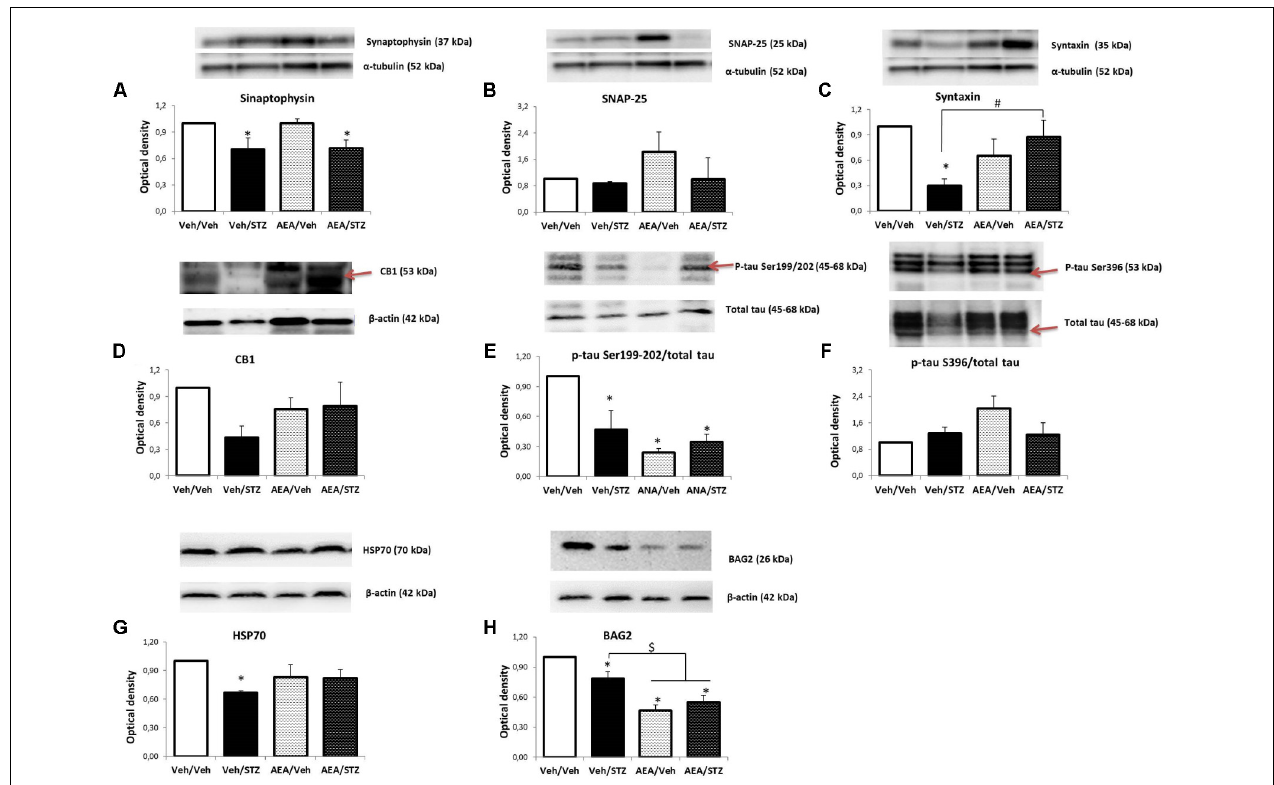
FIGURE 5 | Levels of synaptophysin (A) , SNAP-25 (B) , syntaxin (C) , CB1 receptor (D) , p-tau Ser199/202/total tau (E) , p-tau Ser396/total tau (F) , HSP70 (G) , and BAG2 (H) in the hippocampus of Wistar rats icv-treated with AEA and/or STZ (Veh/Veh, Veh/STZ, AEA/Veh, and AEA/STZ), quantified by Western blotting. Synaptophysin, SNAP-25 and syntaxin levels were normalized by α -tubulin levels. CB1 receptor, HSP70 and BAG2 levels were normalized by β -actin levels. P-tau Ser199/202 and Ser396 levels were normalized by total tau levels. Data are represented as means ± S.E.M of the percentage of groups treated with AEA and/or STZ compared to Veh/Veh, which was considered 1.0 ( n = 3-5 animals per group), ∗ p ≤ 0.05, optical density values are different from Veh/Veh, # p ≤ 0.05, optical density values of AEA/STZ are different from Veh/STZ, $ p ≤ 0.05, optical density values of AEA/Veh and AEA/STZ are different than Veh/Veh and Veh/STZ (one-way ANOVA, followed by Duncan’s post-test). Red narrows indicate the bands that were